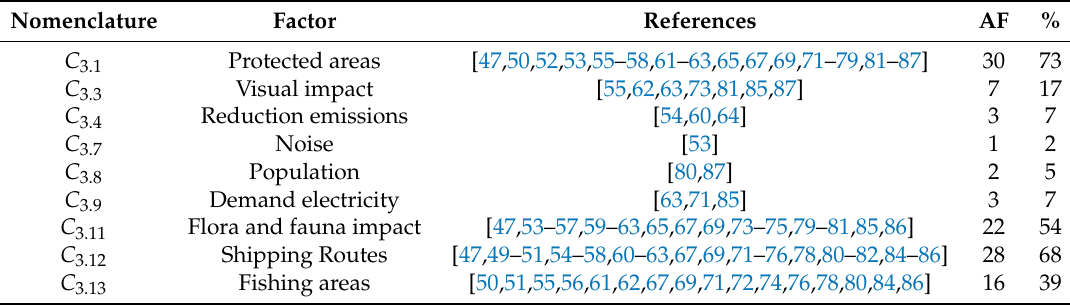
Table 15. Socio-environmental Category ( C 3 )—Offshore wind energy. Quantitative analysis.